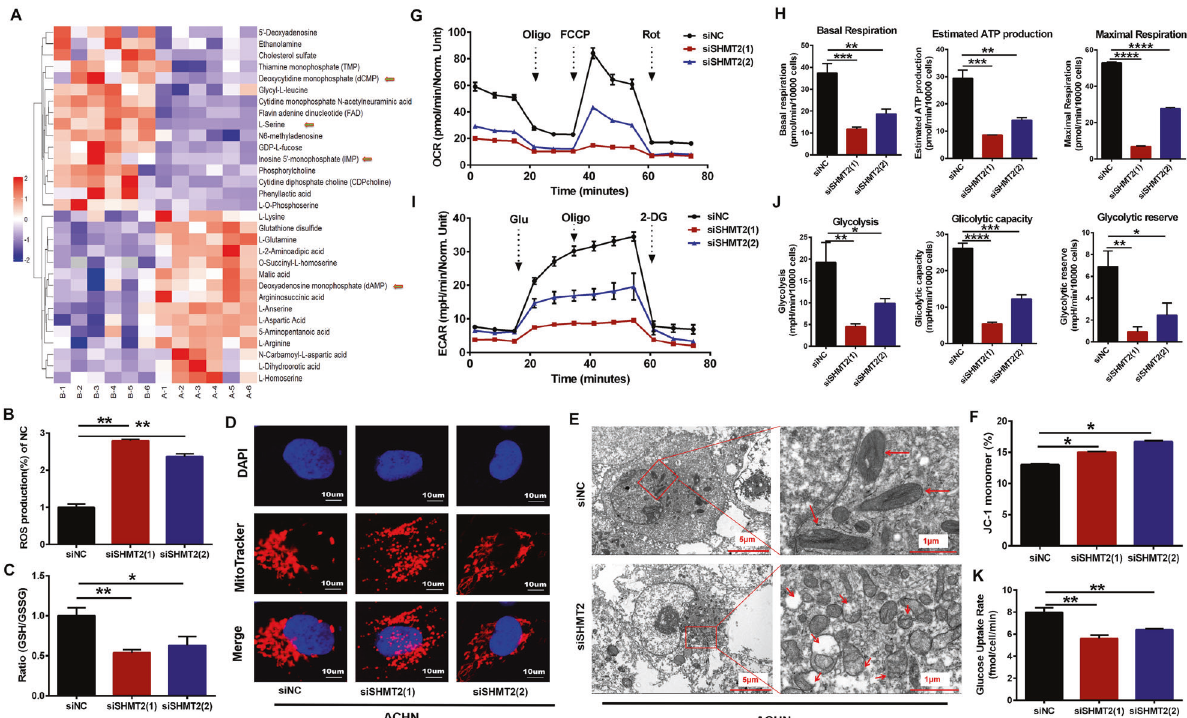
Fig. 6 Effects of SHMT2 knockdown on metabolic reprogramming and mitochondrial structure in ACHN cells. A Heatmap of differentially accumulated metabolites between shNC and shSHMT2 ACHN cells based on the LC-MS metabolite pro fi le. A represented shNC, B represented shSHMT2. B ROS labeled by DCF-DA were detected by fl ow cytometry after SHMT2 knockdown in ACHN cells. All values were normalized to siNC control values. C Cellular GSH/GSSG ratios were measured using a GSH/GSSG-Glo Assay kit. All values were normalized to siNC control values. D Representative confocal microscopy images of ACHN cells stained with Mito tracker (red) and DAPI nuclear staining (blue). Red fl uorescence indicated the active mitochondria. E TEM analysis demonstrated the ultrastructure changes of mitochondria after SHMT2 knockdown in ACHN cells. Red arrows indicated mitochondria. The scale bars in the original image and the enlarged image represents 5 μ m and 1 μ m, respectively. F Quanti fi cation of the monomeric JC-1 levels, indicating a decrease in MMP after treatment with siSHMT2. G OCR measurements in ACHN cells after SHMT2 knockdown. H Basal respiration, estimated ATP production, and maximal respiration based on OCR results. I ECAR measurements in ACHN cells after SHMT2 knockdown. J Glycolysis, glycolytic capacity, and glycolytic reserve based on ECAR results. K Glucose uptake was measured using Promega glucose uptake-Glo assay